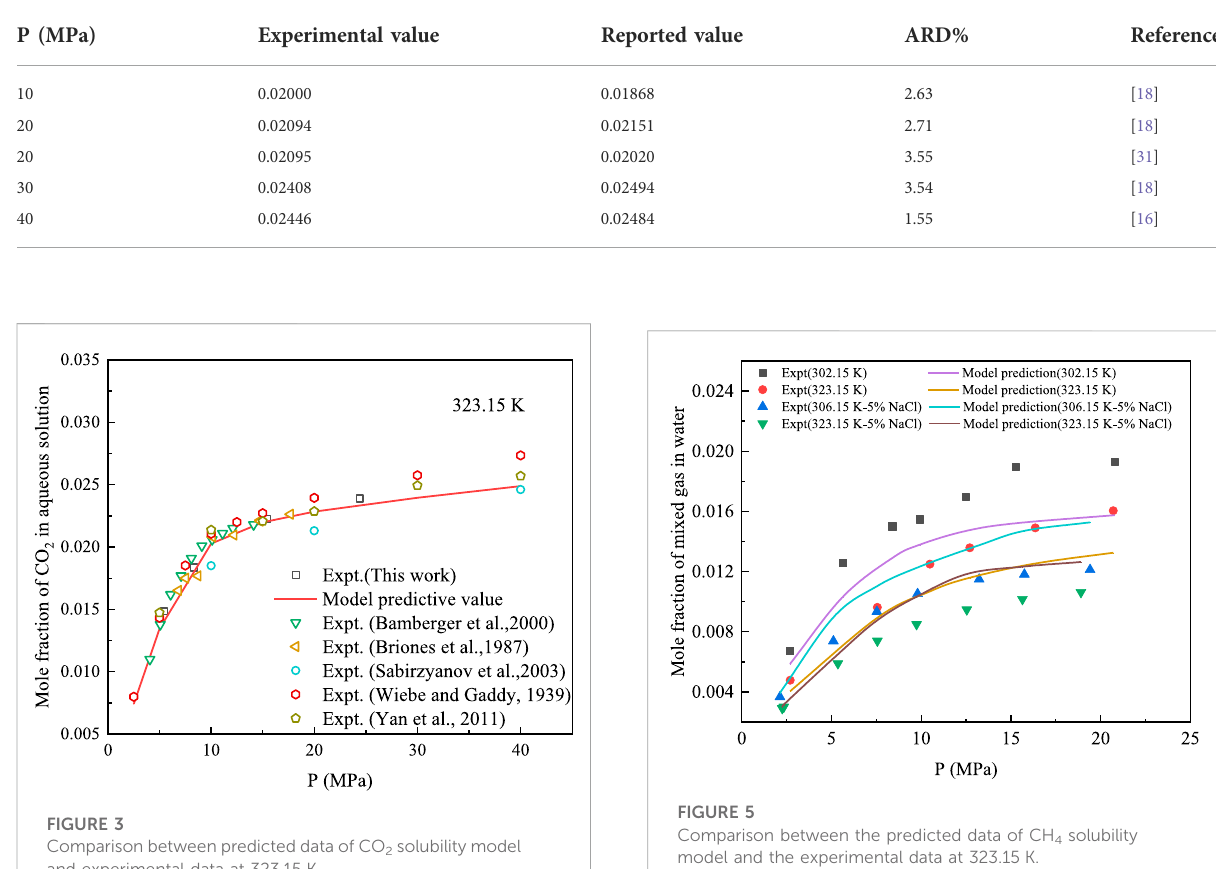
TABLE 1 Comparison between experimental and previously reported values of CO 2 solubility in water measured at 323.15 K.